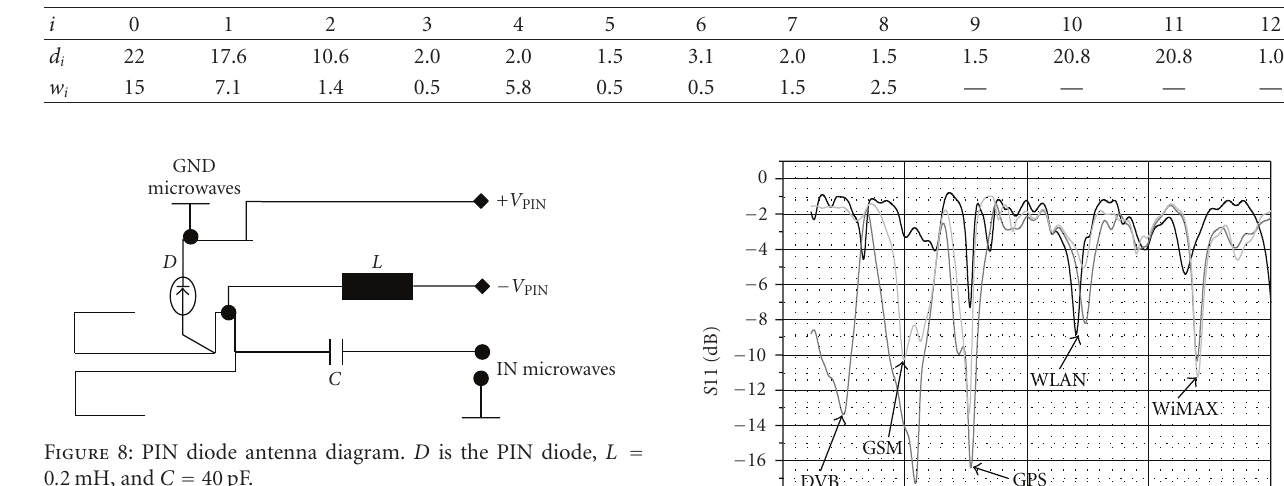
Table 1: d i and w i values, measured in mm, for GPS antenna.